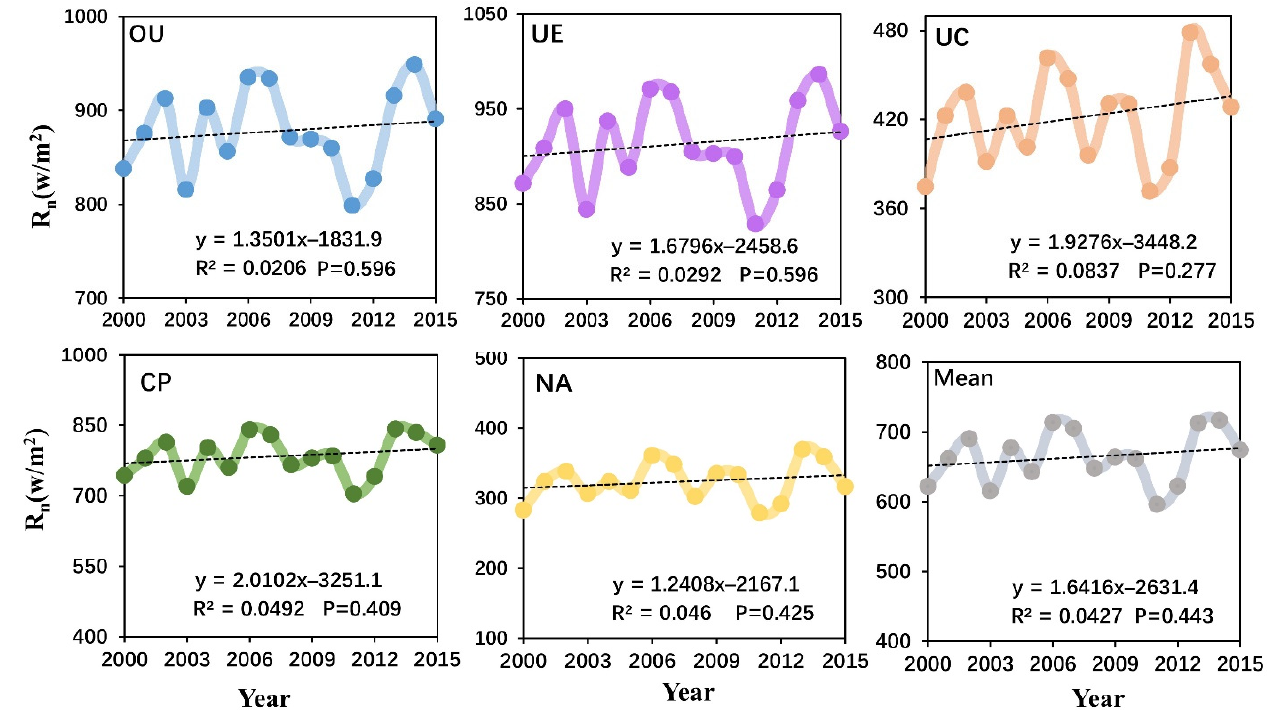
Figure 7. ( a ) Spatial variation in net radiation ( R n ) in the influence area of the YRB for 2000–2015 and ( b ) statistical values for the five use types.